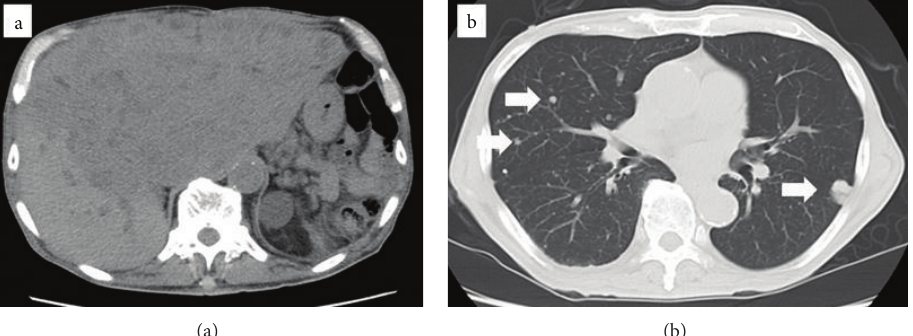
Figure6:Computedtomography(CT)oftheabdomenandchest.Multiplelivermetastases(a)andlungmetastases((b)arrows)weredetected on